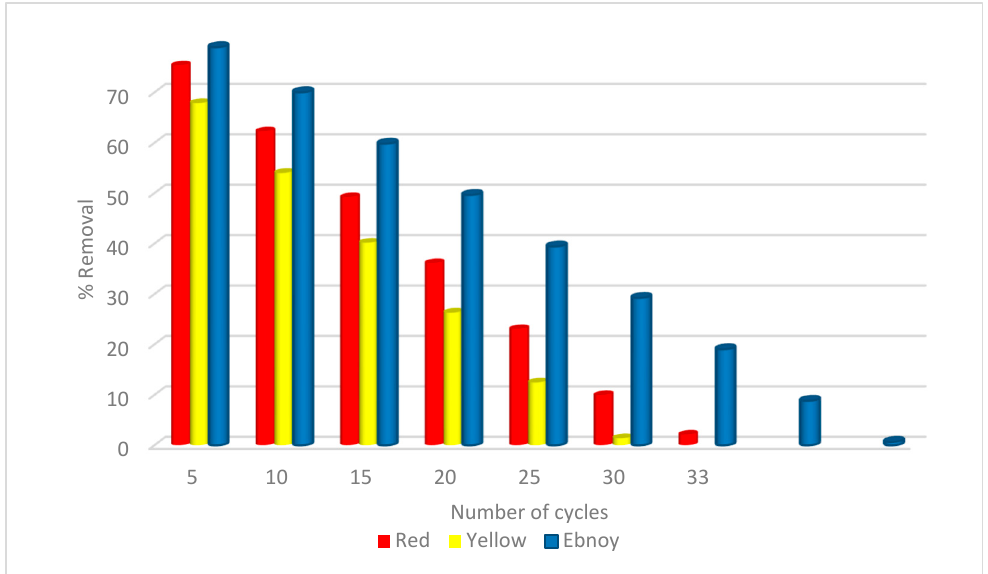
Figure 19. The expected number of cycles to achieve zero capacity of COZ for the three hair dyes.